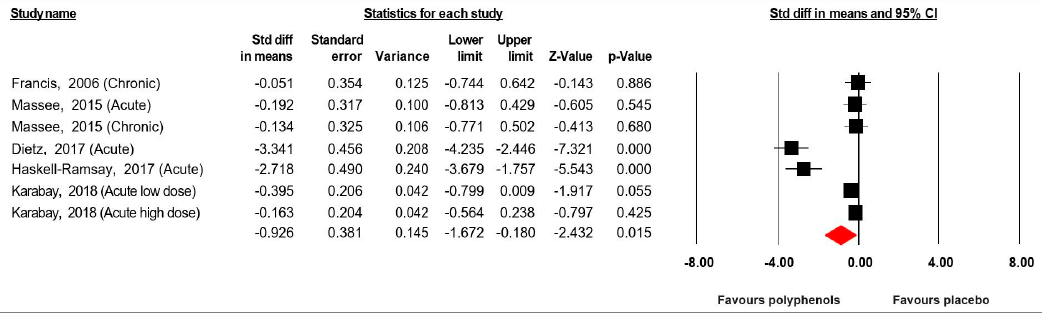
Figure 2. Forest plot of studies investigating the effect of (poly) phenols-rich supplementation on simple reaction time (SRT). The black symbol for std diff of each individual study and the red for the std diff of all pooled studies.